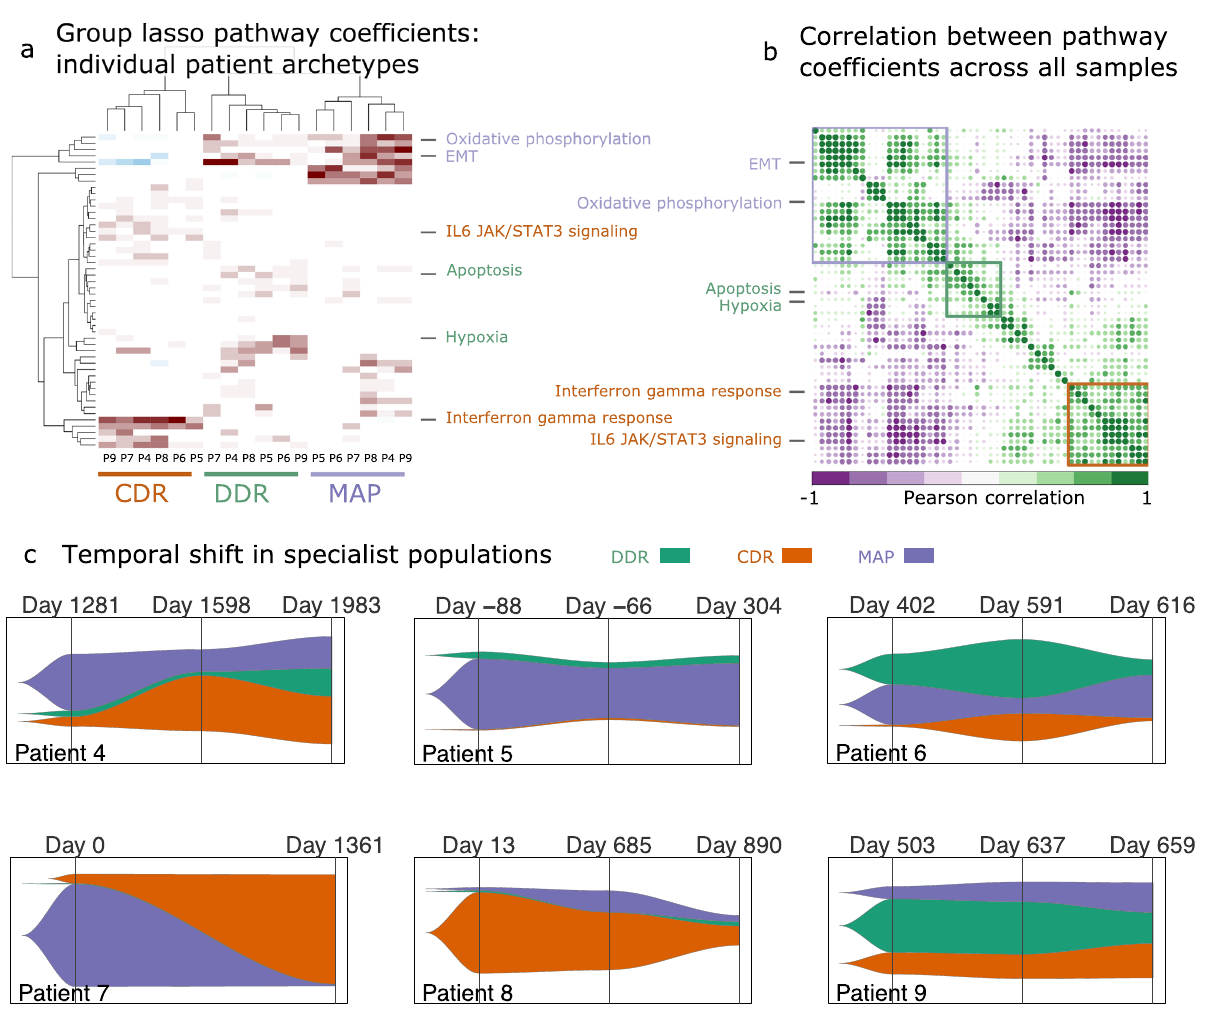
Fig. 3 Archetype evolution in individual patients. a Hierarchical clustering of group-lasso coef fi cients for archetypes determined for each longitudinal cohort patient across all time points. b Correlation plot of pathway scores across all samples with three major clusters indicated using colored boxes. Key pathways that de fi ned the biological phenotypes associated with the archetypes in the integrated dataset are shown for both the hierarchical clusters and the correlation plots. c Fishplots displaying the temporal shift in the population of task specialists for each patient. The three major tasks are represented with their respected abbreviations (DDR DNA-damage repair, MAP metabolism and proliferation, and CDR cell defense